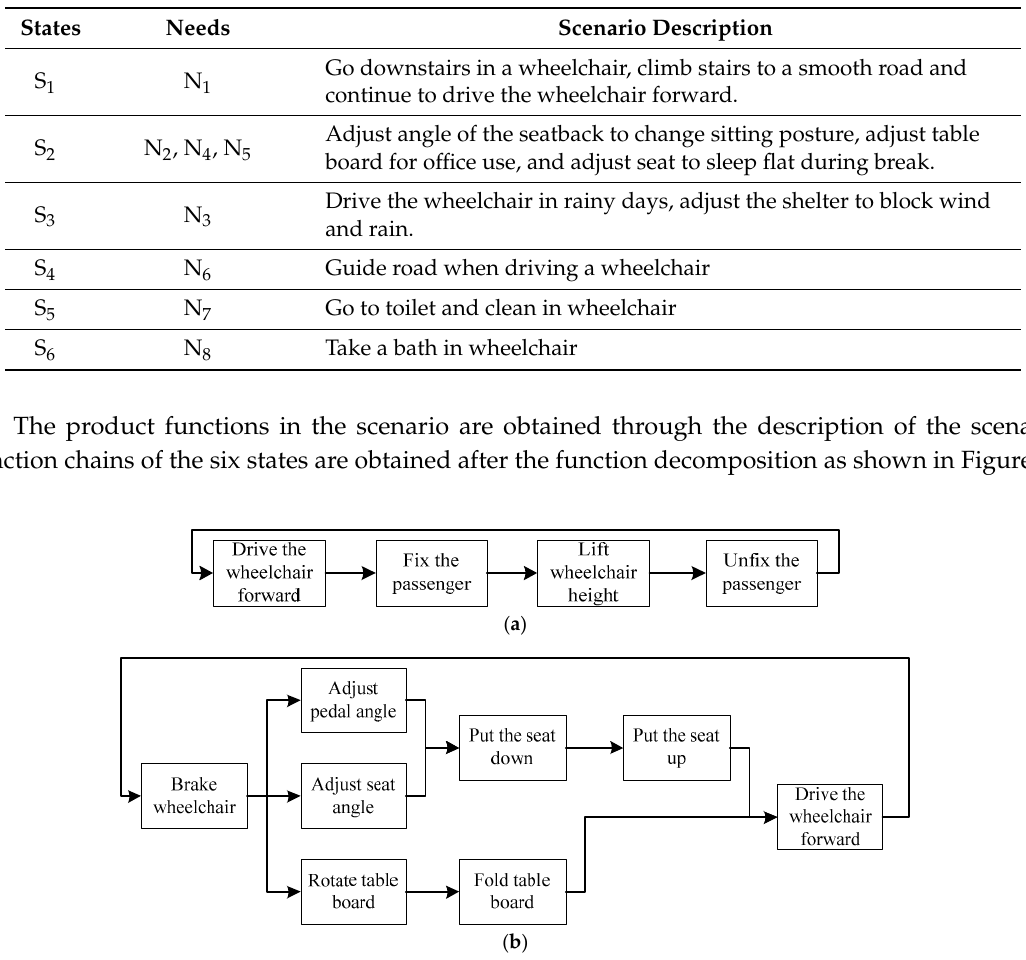
Figure 8. Segmentations of needs-related undirected graph. Table 6. Scenario description of six states. Table 6. Scenario description of six states.